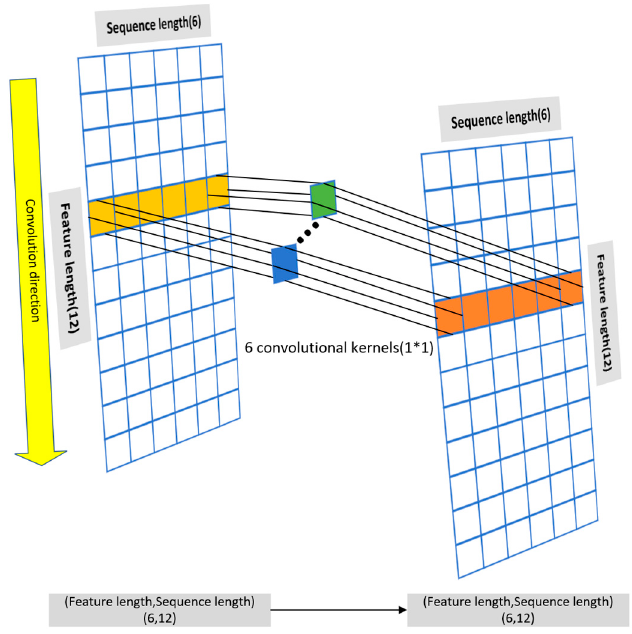
Figure 10. Festure_Convolution. Figure 10.